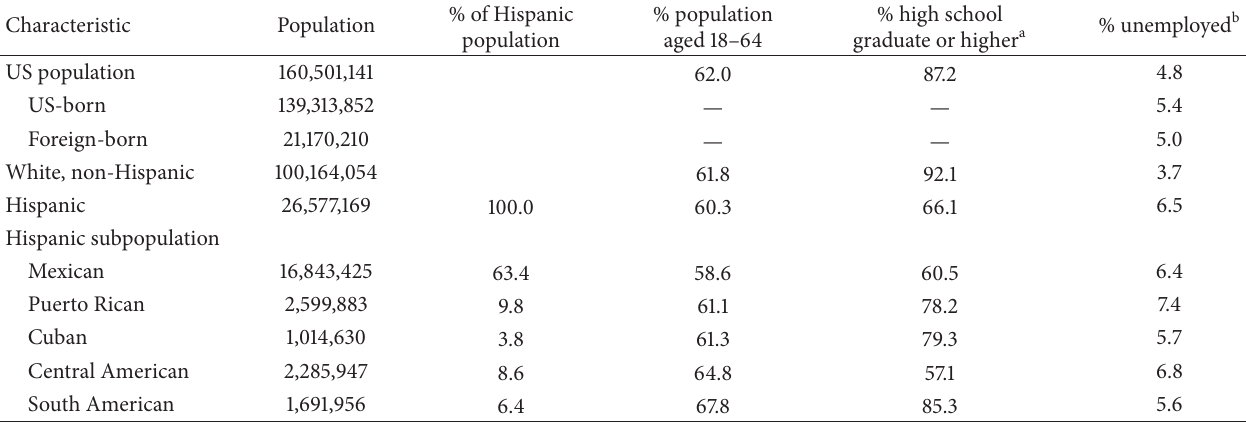
Table 1: Selected sociodemographic characteristics of the US female population, by nativity, race/ethnicity, and Hispanic subpopulation: American Community Survey, 2013.